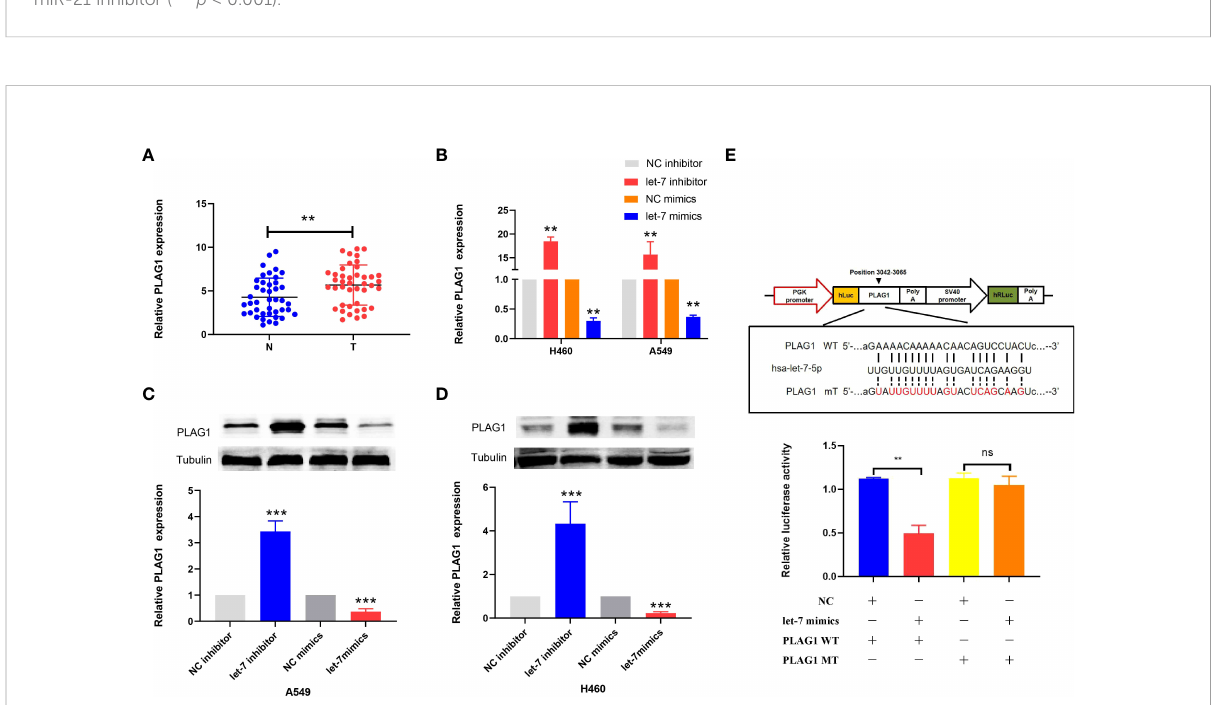
FIGURE 7 The expression of PLAG1 in lung cancer tissue and the relationship between let-7 and PLAG1 as demonstrated by Western blotting and luciferase assays in cells. (A) The expression of PLAG1 in lung cancer tissue was higher. (B – D) The relative PLAG1 expression after transfection of let-7 inhibitor or mimics in lung cancer cell lines. (E) The binding sites of let-7 and PLAG1 and the relative luciferase activity of the let-7 mimic cotransfected with WT/MT were evaluated (ns, no signi fi cance; ** p < 0.01; *** p <